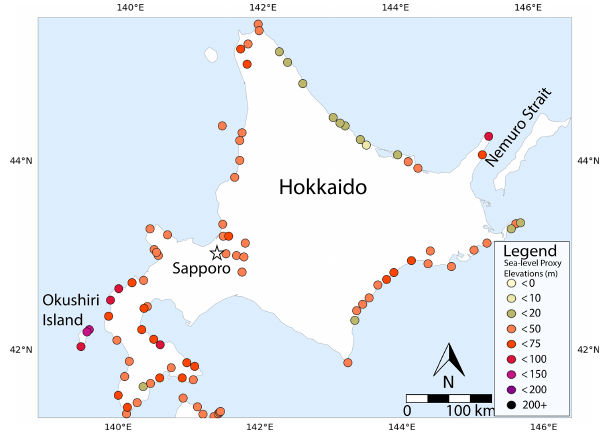
Figure 5. Sea-level elevation proxies in northern Honshu. Sea-level indicators (circles) with elevation range indicated by color (see leg- end). Reference cities are indicated by